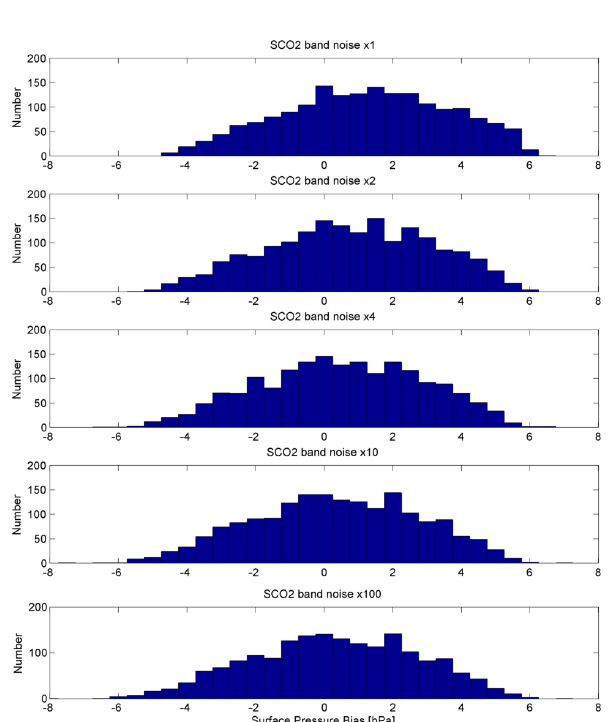
Fig. 11. Histograms of the error in retrieved surface pressure (hPa) for different scaling factors of the noise in the strong CO 2 band. The error is the difference between the retrieved surface pressure and the measured surface